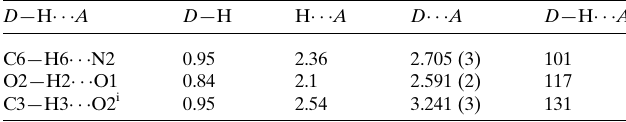
Table 1 Hydrogen-bond geometry (A˚ , (cid:3)